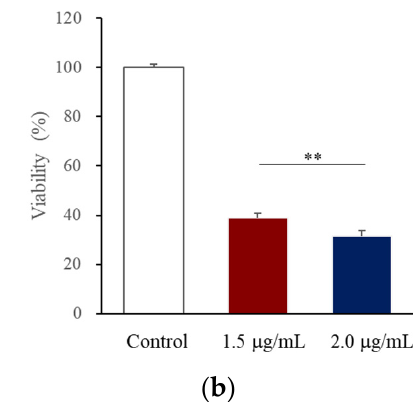
Figure 3. PLXNA4 gene expression after recombinant PLXNA4 protein treatment in human umbilical-cord-derived mesenchymal stem cells. Cells were harvested 4 days after recombinant PLXNA4 protein treatment. ( a ) Real-time PCR data of each protein. ( b ) MTT data show the inhibition of proliferation. Column heights correspond to mean values and error bars to standard deviations ( n = 3). * p < 0.05, ** p < 0.01.